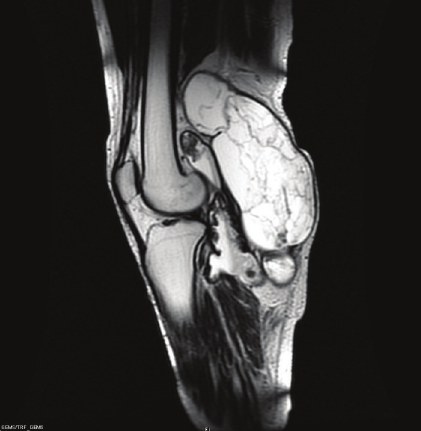
Figure 4: The sagittal section of the popliteal mass on MRI showed the enormous mass.